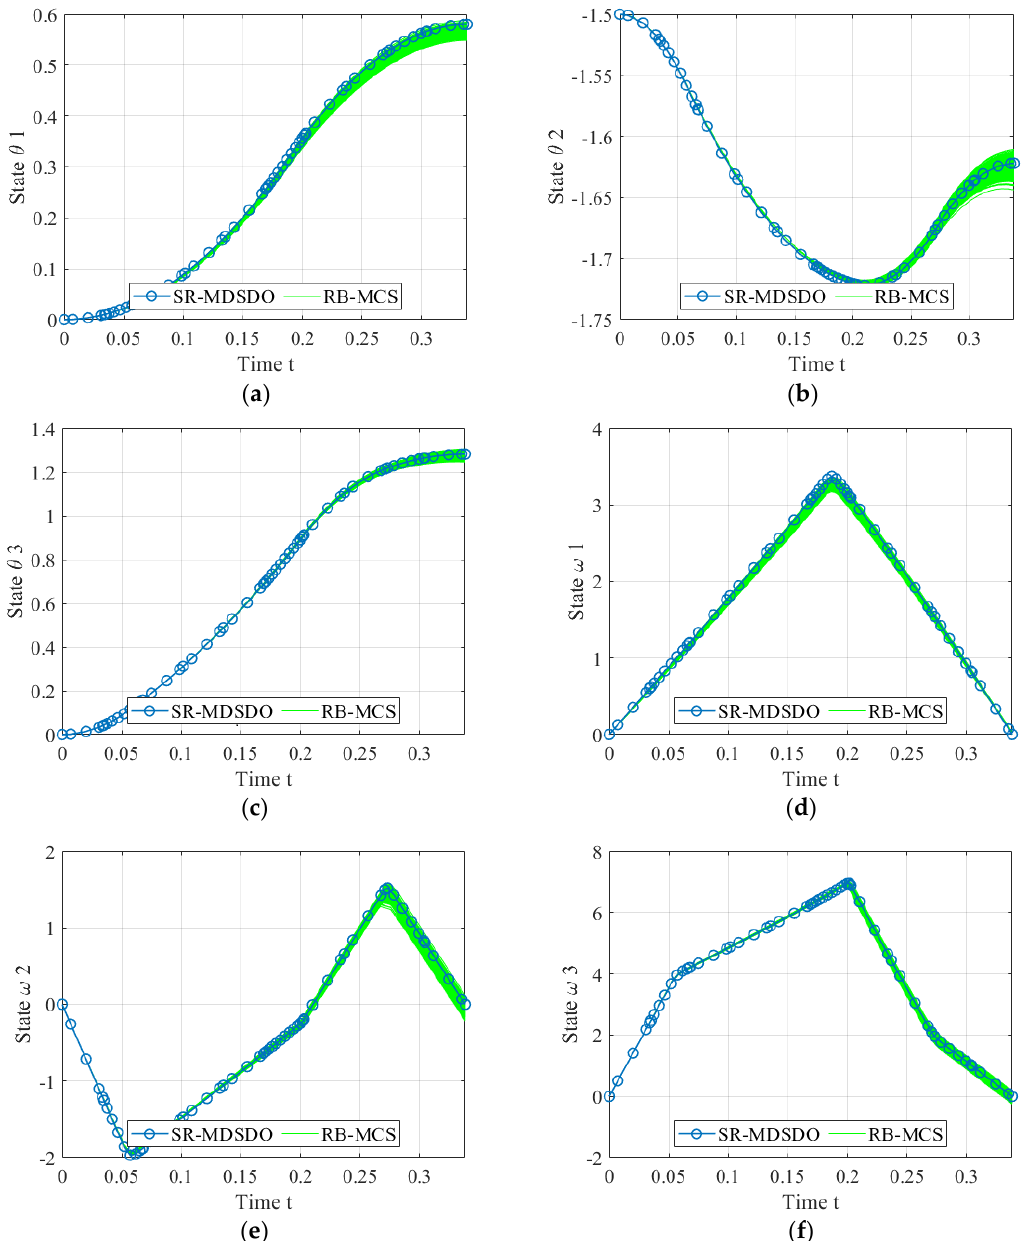
Figure 14. The uncertainty influence on state trajectories under C-MDSDO. ( a ) State trajectories of θ 1 .